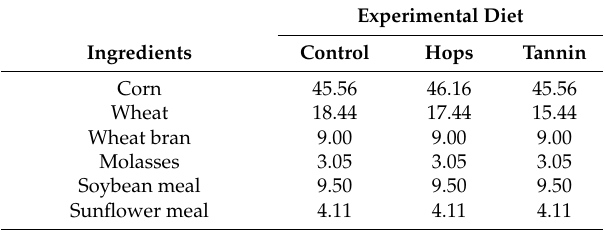
Table 1. Ingredients (%) and chemical composition (g / kg) of experimental